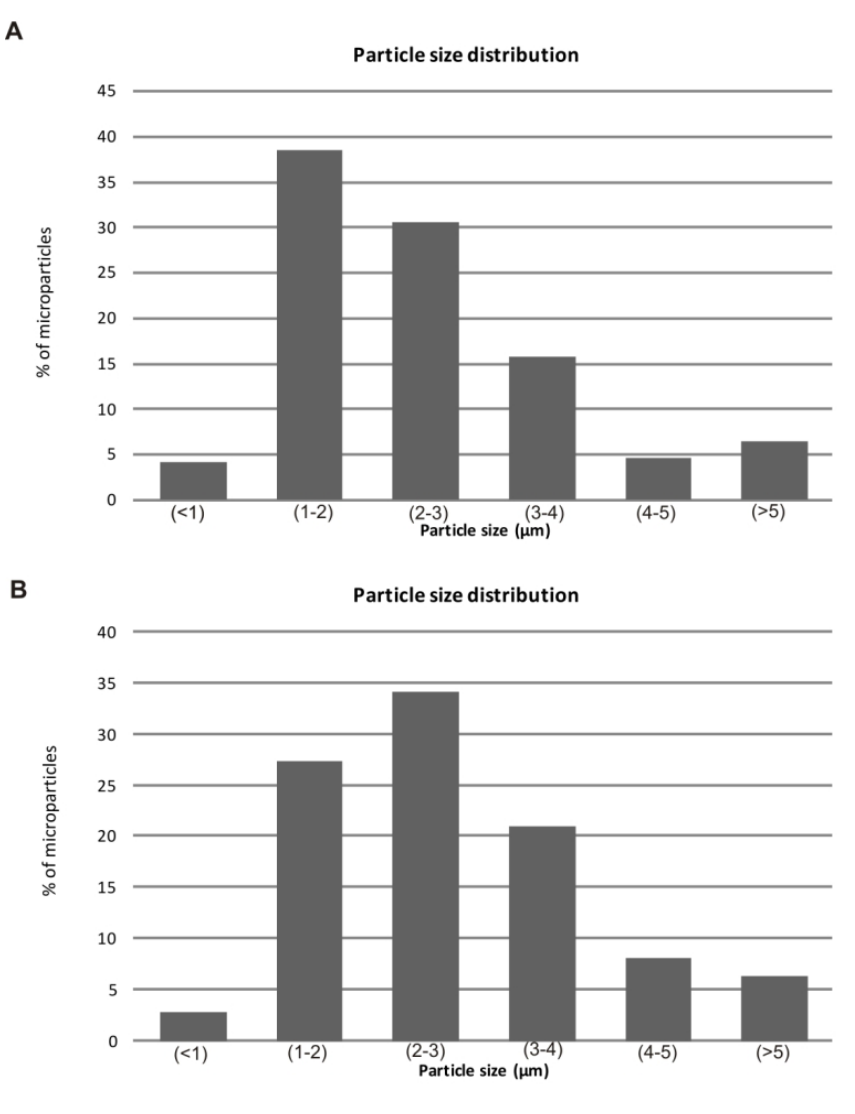
Figure 1. Extract loaded-microparticle size frequency distribution. ( A ) Alginate microparticle; ( B ) Chitosan microparticle.